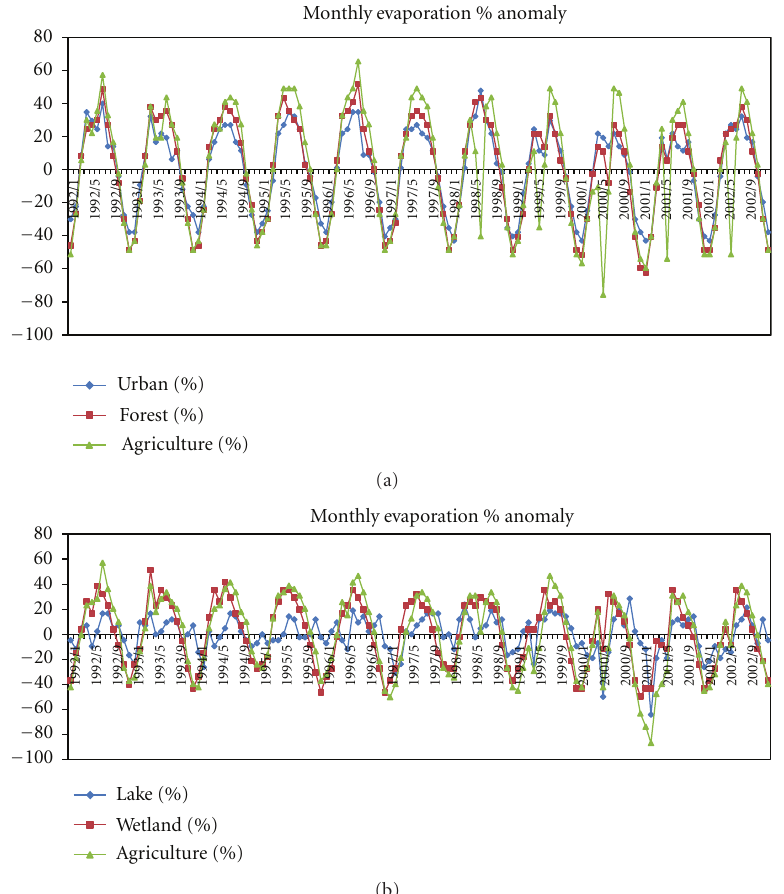
Figure 9: (a) Interannual variations in monthly evaporation in Northeast Florida. (b) Interannual variations in monthly evaporation in South Florida.